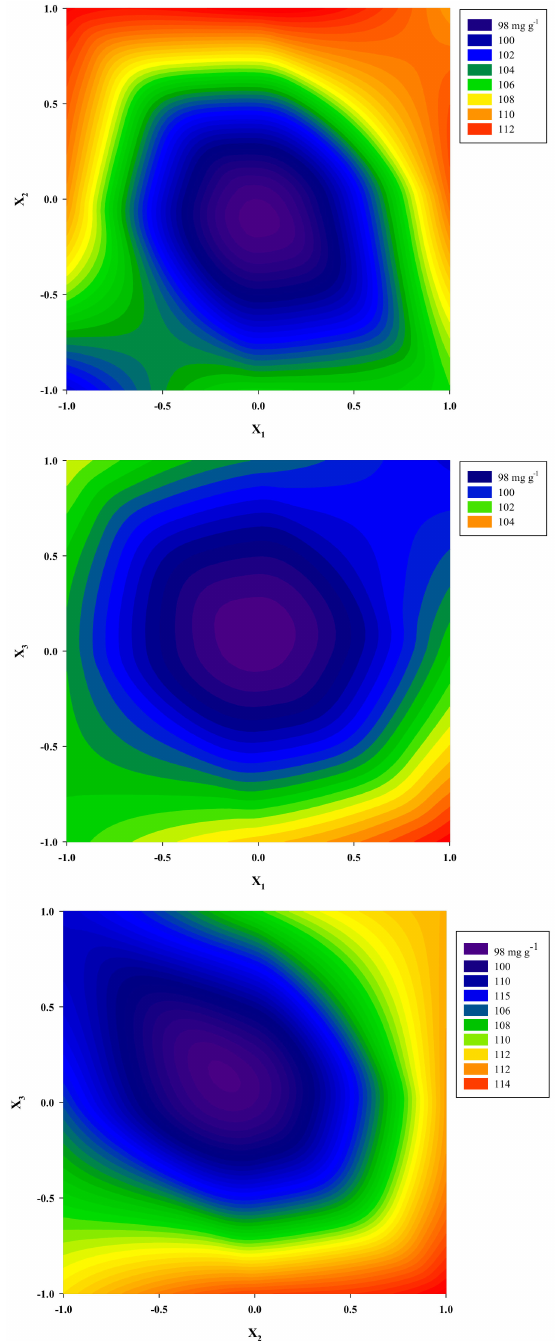
Figure 3. Contour plots showing the e ff ect of independent (process) variables on the response (Y TP ). Upper, middle, and lower plots correspond to covariation of X 1 and X 2 , X 1 and X 3 , and X 2 and X 3